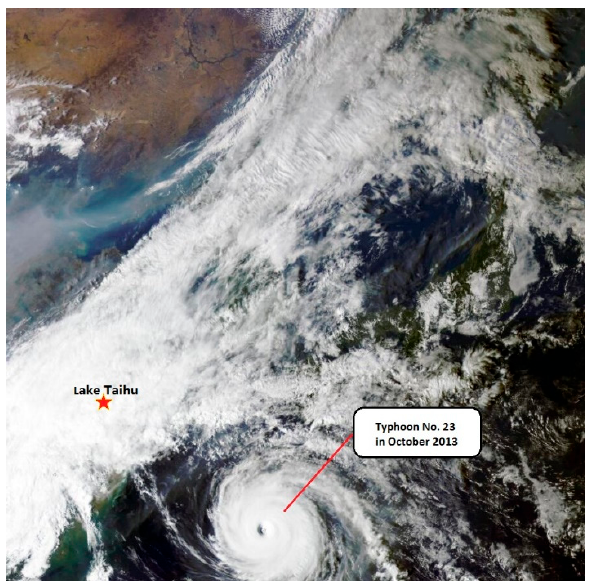
Figure 9. GOCI image taken at 14:15 pm on 7 October 2013 (Typhoon No. 23).